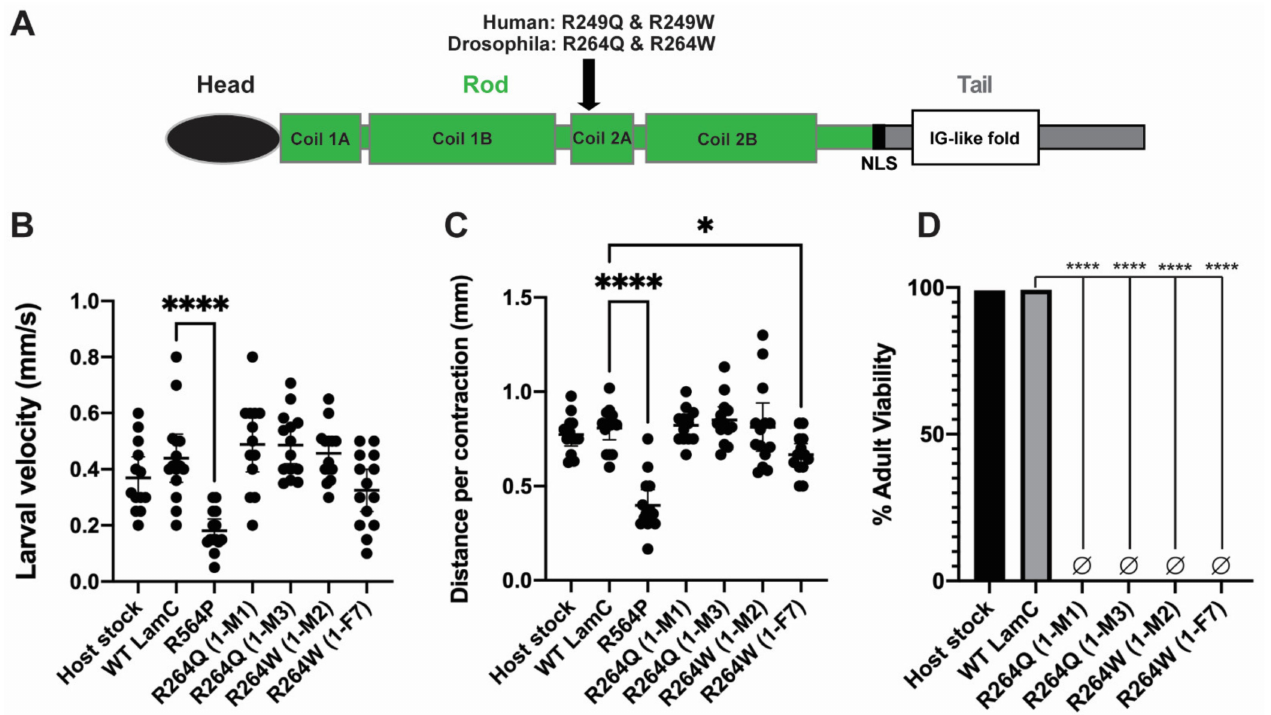
Figure 4. Effects of muscle-specific expression of mutant Drosophila LamC transgenes on larval motility and adult viability were analyzed. ( A ) Diagram of lamin A/C showing domains and location of the amino acid substitutions under study. ( B ) Velocity measurements were made on the host stock and transgenic larvae expressing either wild-type or mutant LamC exclusively in the larval body-wall muscles. For the transgenic larvae, the amino acid substitution is indicated along the X-axis; parentheses represent the strain designation). Velocity values are expressed as the mean ± standard deviation. n = 13–15 larvae per genotype. LamC R564P was previously shown to reduce motility and was used as a positive control. **** p < 0.0001 ( C ) Distance per contraction of third instar larvae were measured for the host stock and transgenic larvae expressing either wild-type LamC or mutant LamC exclusively in the larval body-wall muscles. Distance per contraction measurements are expressed as the means ± standard deviation. n = 13–15 larvae per genotype. * p < 0.05, **** p < 0.0001 ( D ) The percent adult viability was measured for the host stock and transgenic flies with larval body-wall muscle-specific expression of mutant LamC . Ø indicates zero adults were viable. n = 174–426 adults per genotype. **** p <